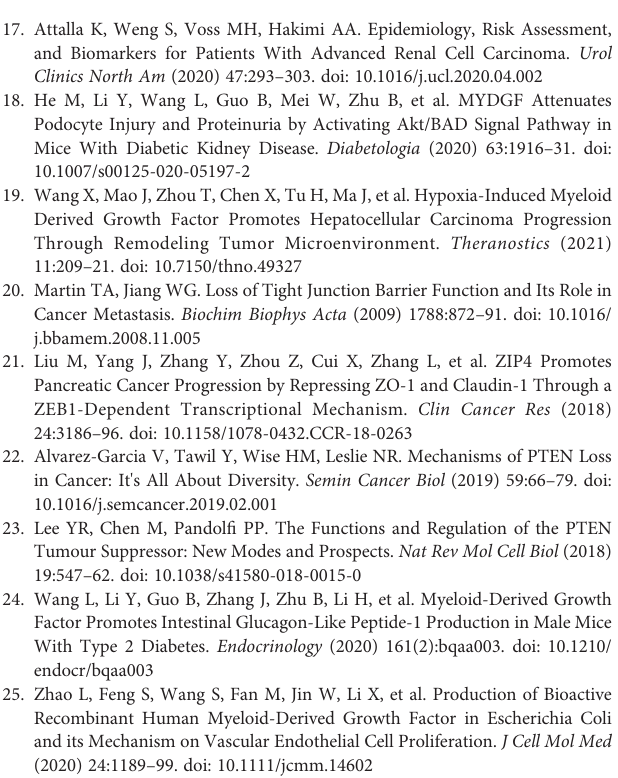
Supplementary Table 2 | ROC curve analysis of the prognostic and diagnostic potential of C19orf10 in KIRC (TCGA dataset). Abbreviations: AUC, area under the curve; TNM, Tumor node